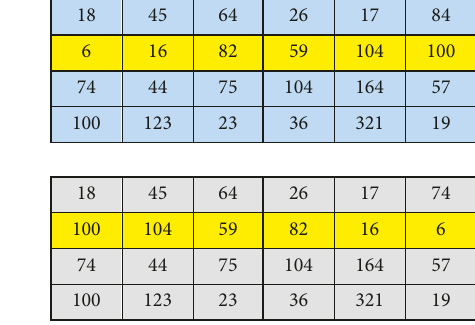
Figure 4: Mutation operator. Table 2: Parameter